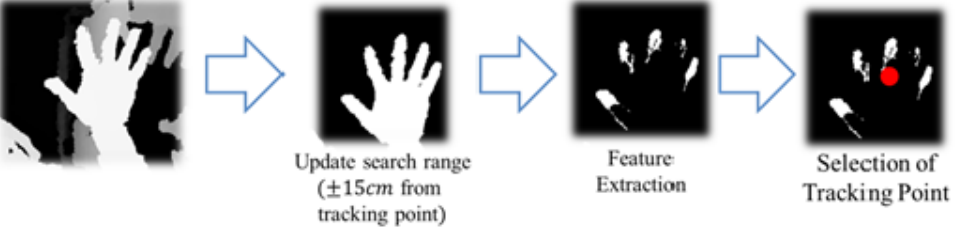
Figure 5. Overview of the proposed hand tracking algorithm.